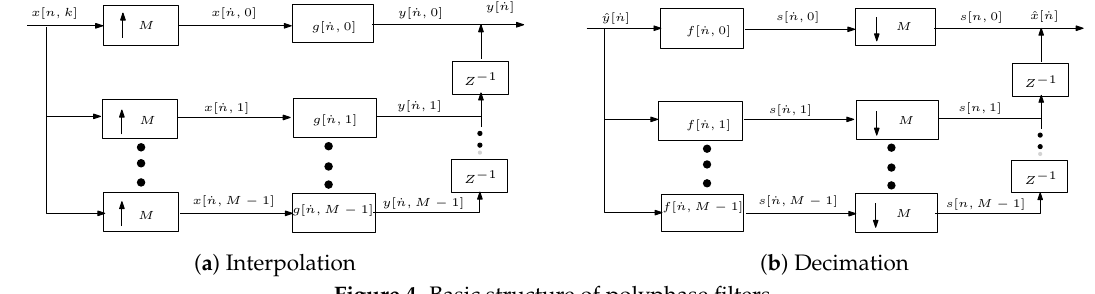
Figure 4. Basic structure of polyphase